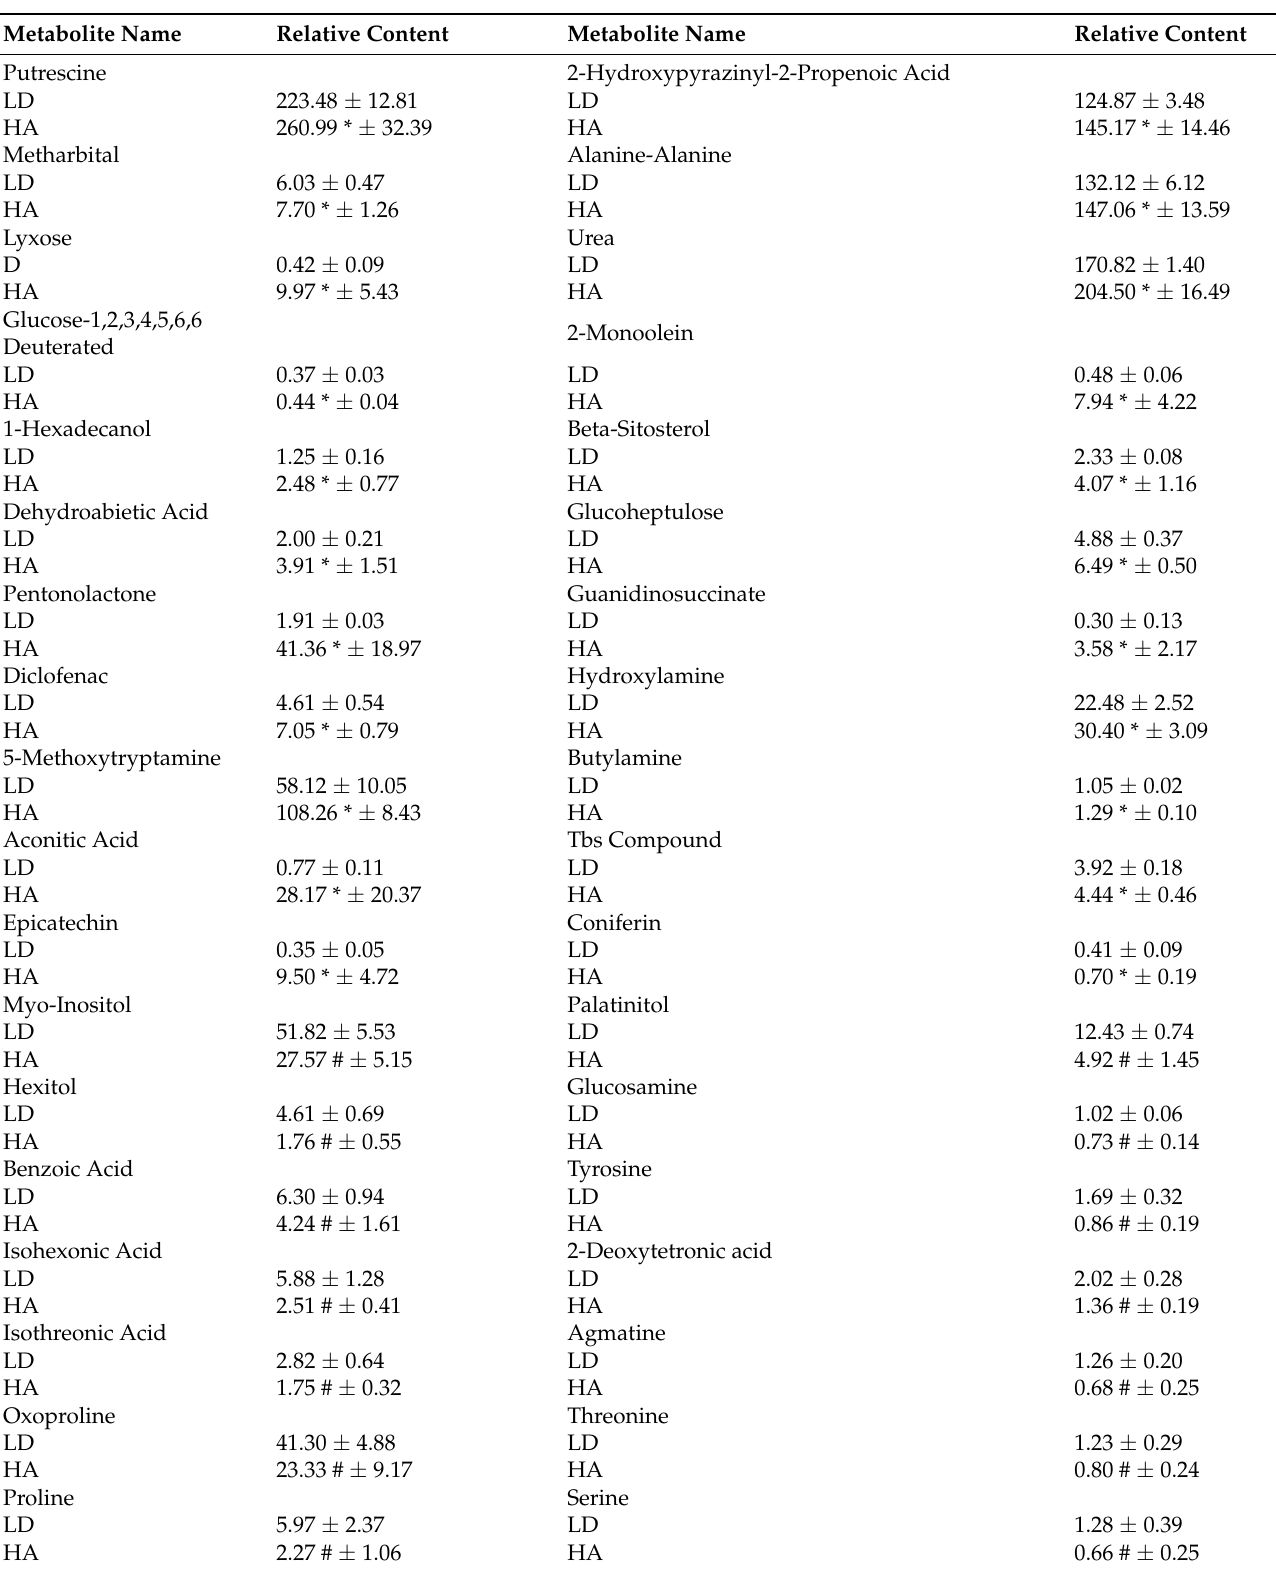
Table 5. The relative contents of the metabolites in rhizosphere soil were changed by humic acid on the decline diseased bayberry